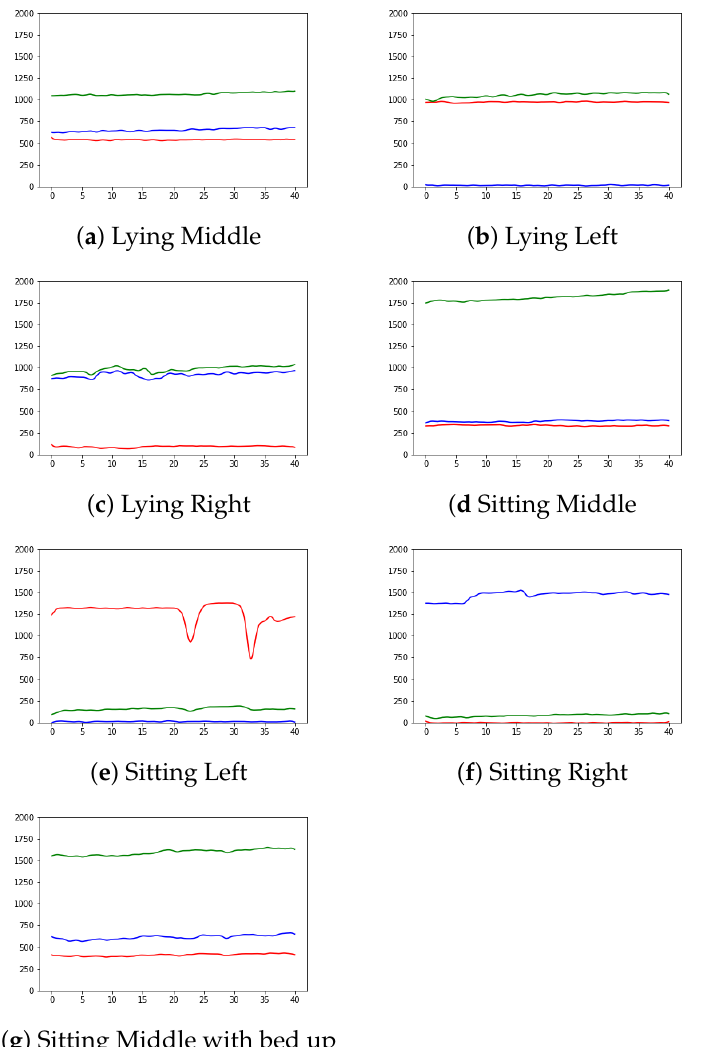
Figure 11. Sensor value depiction according to the position of the user on the bed. Each color is associated with a sensor, red with the left sensor, green with the central sensor and blue with the right